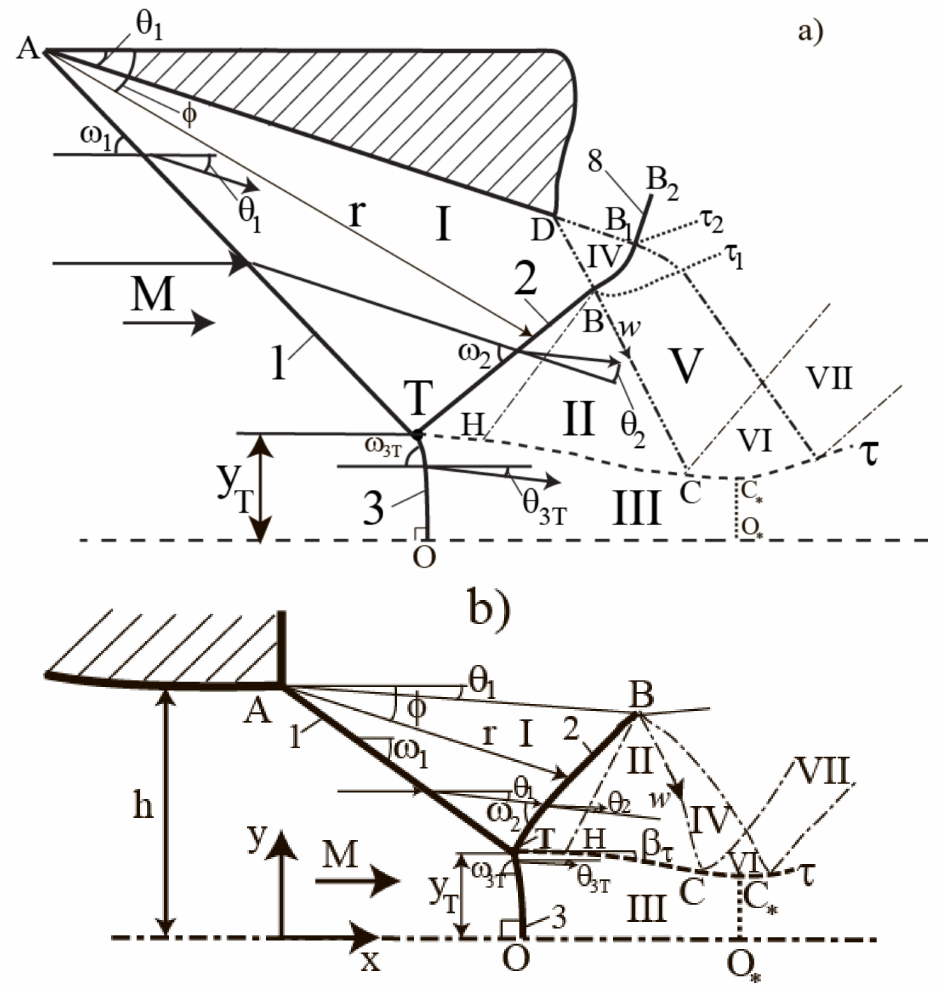
Figure 1. Patterns of flows with Mach reflection: ( a ) in a narrowing channel between two wedges; ( b ) in overexpanded gas jet flow. Here, M is the Mach number of unperturbed flow; 1 ( AT ) is the incident shock; 2 ( TB ) is the reflected one; 3 (TO) is the main shock (Mach stem); T is the triple point; τ is the emanating slipstream; β τ is the local slope angle of the slipstream τ ; θ 1 and θ 2 are flow deflection angles on shocks 1 and 2; θ 3 T is the flow deflection angle on shock 3 at triple point T ; ω 1 and ω 2 are slope angles of the shocks 1 and 2 to flow velocity vectors upstream them; ω 3 T is the slope angle of the shock 3 in triple point T ; h is the width of the channel; y T is the sought Mach stem height; ( r , φ ) are the distance and the polar angle in cylindrical coordinate system centered in point A ; HB is the first-family acoustical characteristic that comes into point B ; I if flow region behind the incident shock 1; II ( BTC ) is the flow region downstream the reflected shock that can be approximated as Prandtl–Meyer flow with straight first-family characteristics; III is the flow region behind the Mach stem (“virtual nozzle” with critical section C ∗ O ∗ ); IV is the expansion fan; V (Figure 1a) is the refracted expansion fan resulting in the interaction of wave IV with the curvilinear shock BB 1 ; VI is the reflection zone o expansion wave; VII is the reflected wave; BC is the first acoustical characteristic of the expansion wave that turns the slipstream τ ; τ 1 and τ 2 (Figure 1a) are weak tangential discontinuities; 8 ( B 1 B 2 , Figure 1a) is the resulting shock after the interaction with the expansion wave